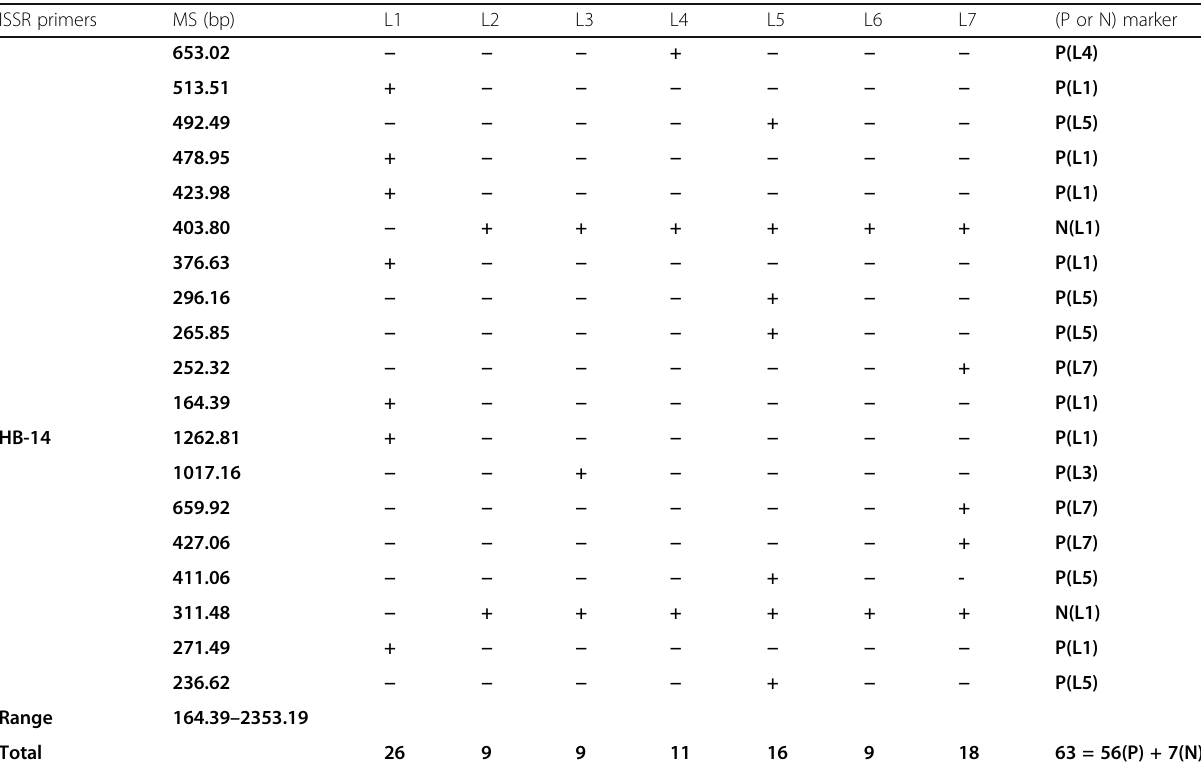
Table 8 Mapping of positive (P) and negative specific markers for the 7 wheat lines using six ISSR primers (Continued) ISSR primers